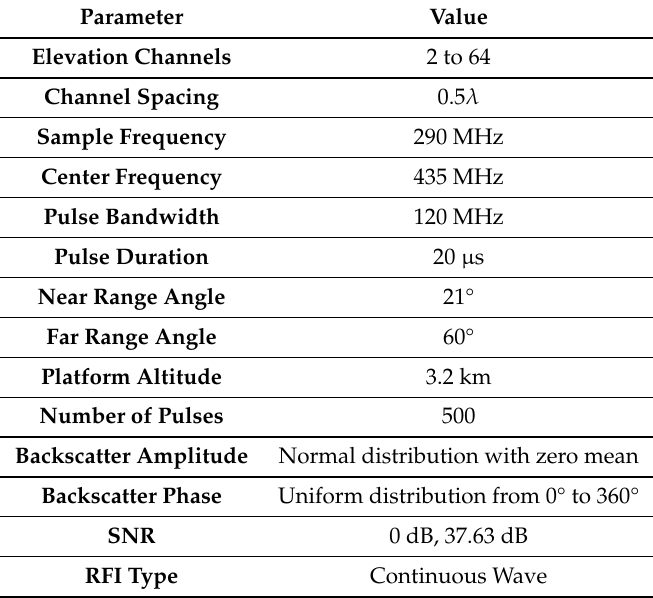
Table 1. Parameters used for the simulation of the Synthetic Aperture Radar (SAR) and Radio Frequency Interference (RFI)